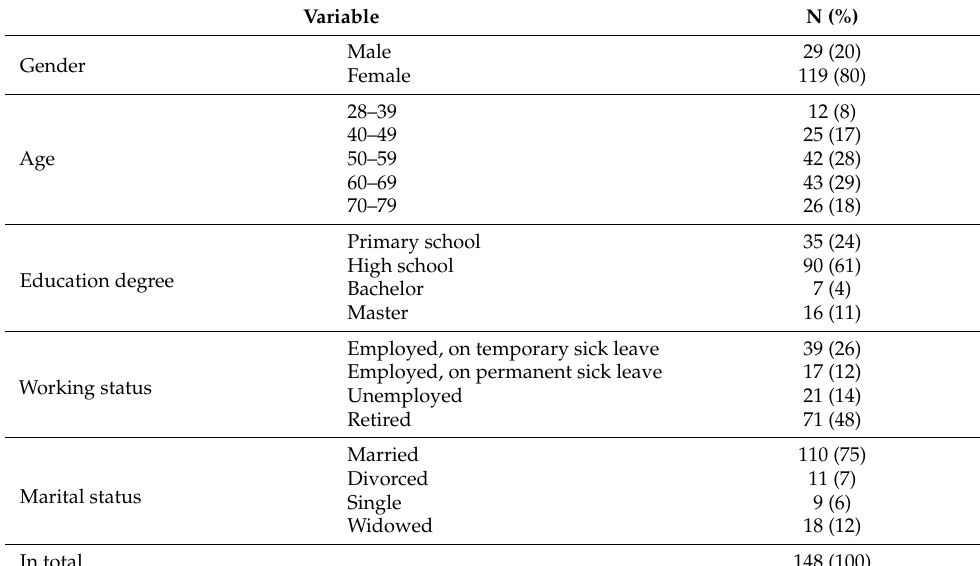
Table 1. Sociodemographic characteristics of the participants ( n =